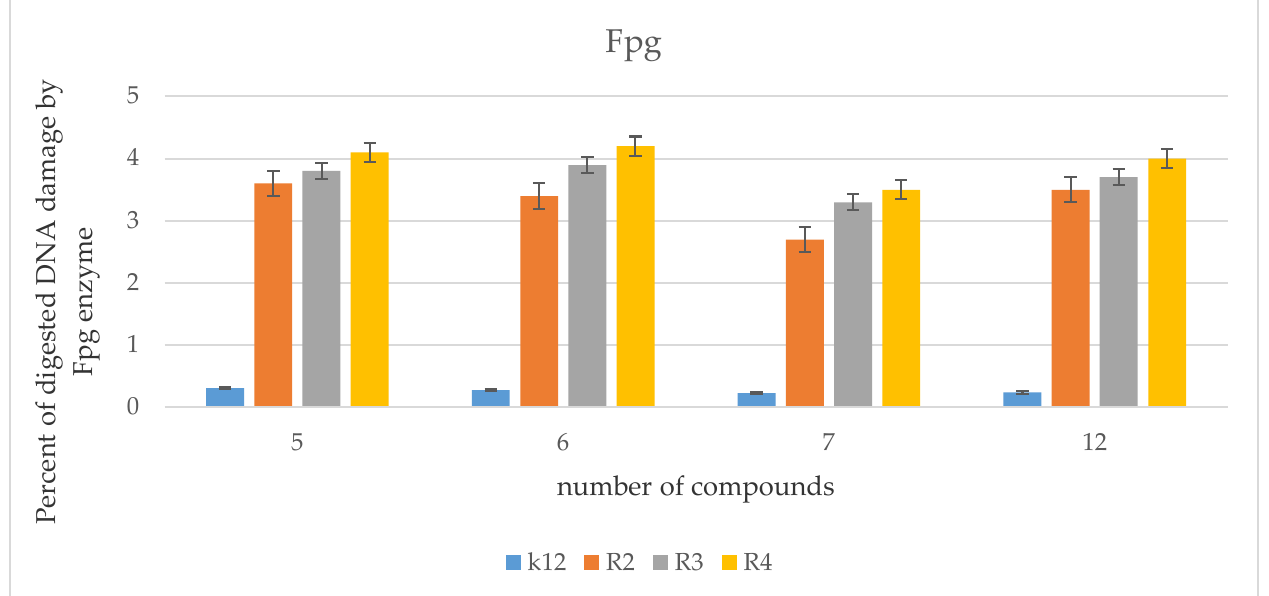
Figure 7. Percentage of plasmid DNA recognized by Fpg enzyme ( y -axis) with model bacterial, K12, and R2 – R4 strains ( x -axis). All analyzed compounds numbered were statistically significant at <0.05 (see Table 2).